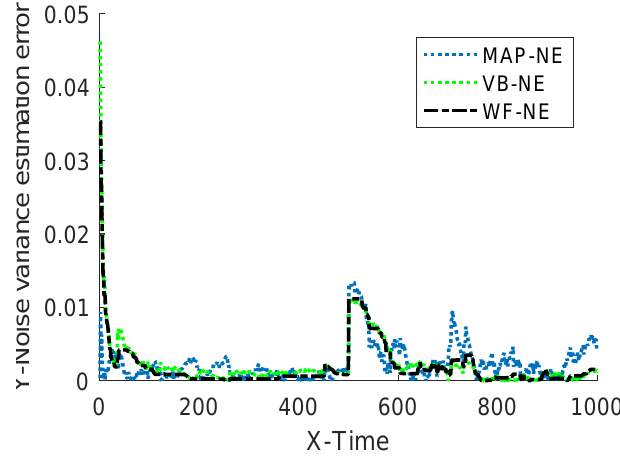
Figure 5. Absolute estimation error of measurement noise